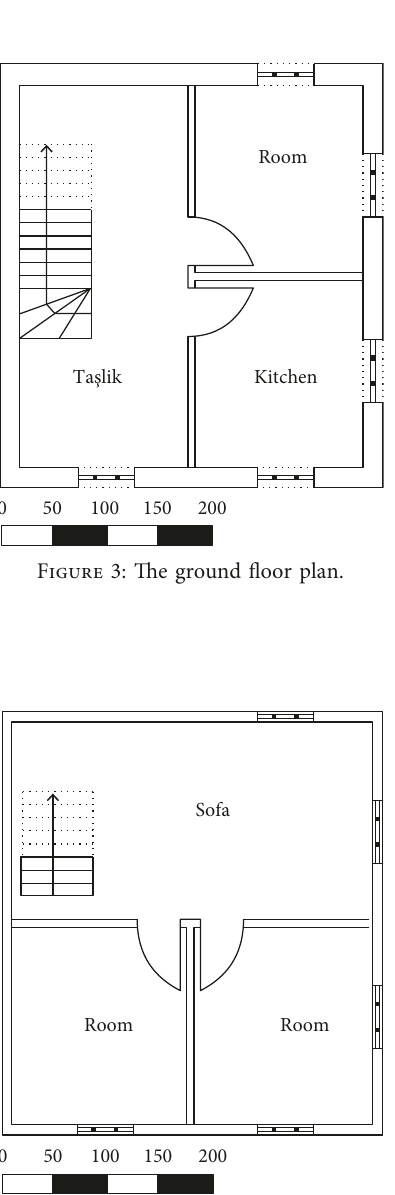
Figure 2: Location of Bursa ¨Ur¨unl¨u and G¨or¨ukle villages in Google Earth view.